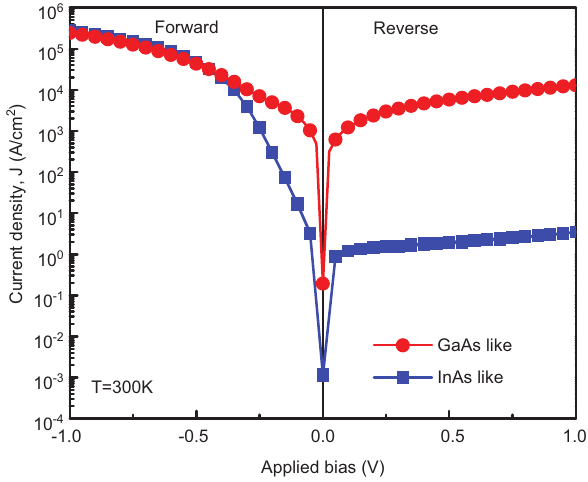
Figure 25 Measured I-V characteristic of GaAs-like interface and InAs-like interface reverse-biased GaAs diode at T = 300 K. Almost four orders higher leakage current density was observed from the GaAs-like interface GaAs p + -i-n + diode than the InAs-like interface p + -i-n + diode. Reprinted from Ref. [11], with permission, from the American Institute